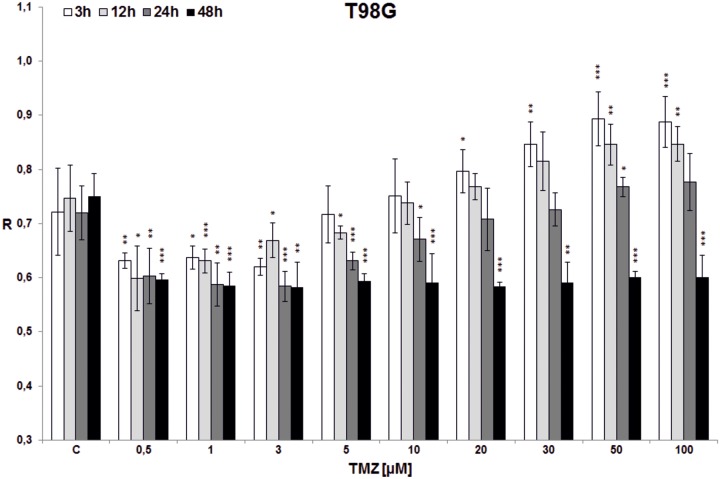
The effect of TMZ on total DNA methylation of T98G cell line.The analysis was performed after 3 (white bars), 12 (light grey bars), 24 (dark grey bars) and 48 (black bars) hrs of incubation in a given TMZ concentration (0.5–100 μM). Control cells (C) were treated with DMSO only. The R values are means from three experiments ±SD. Asterisks indicate a significant difference (*p < 0,05, **p < 0,01, ***p < 0,001) from the control (DMSO) value. Striking DNA hypomethylation happens in therapeutically achieved concentrations (less than 5 μM). Significant DNA hypermethylation is achieved at minimal TMZ concentrations of 20–50 μM in 3–24 hrs incubation time. Clear demethylating tendency is seen with 48 hrs incubation time in all TMZ concentrations.